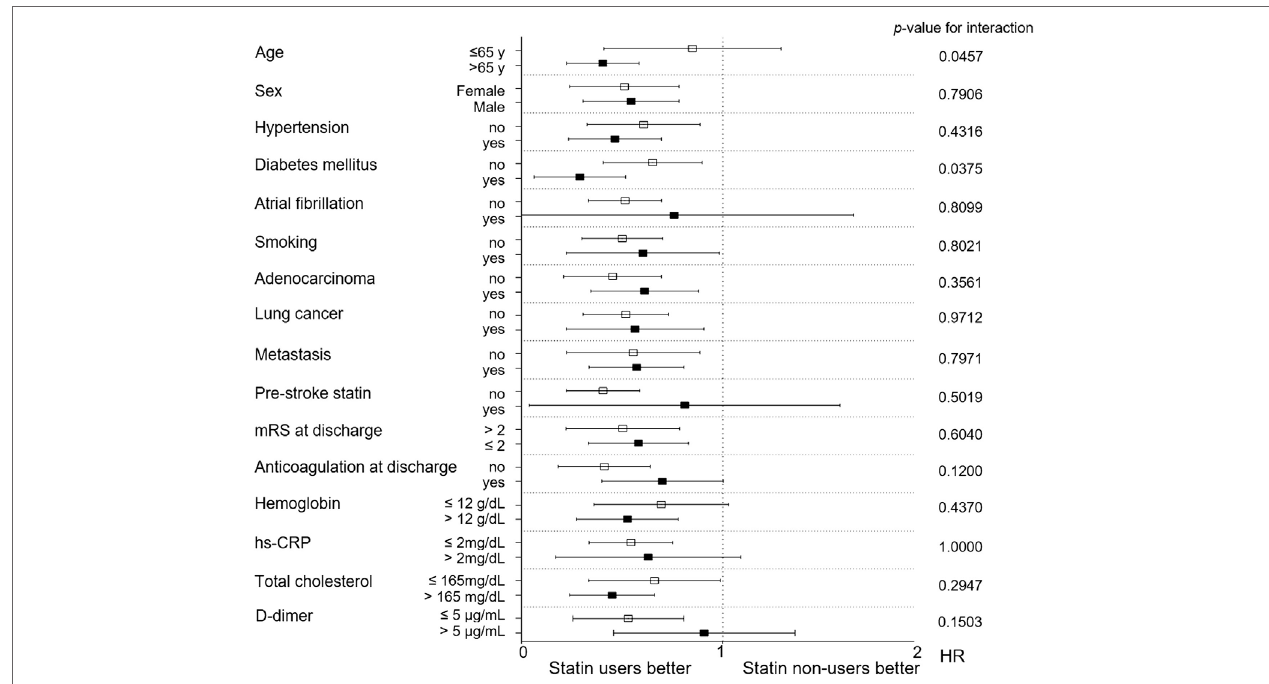
FigUre 4 | Subgroup analysis of the effect of statins on survival outcome. CRP, C-reactive protein; HR, hazard ratio; mRS, modified Rankin Scale*Subgroup analysis for D-dimer was conducted for 256